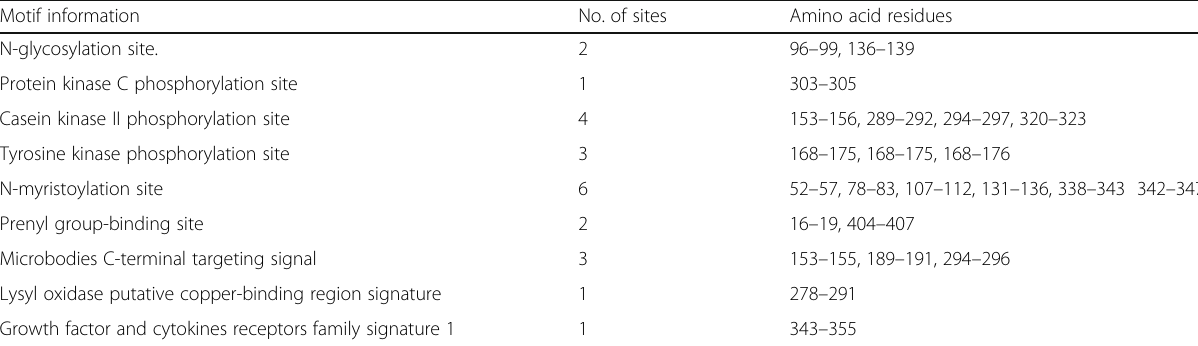
Table 3 Motif regions present in the protein sequence Motif information No. of sites Amino acid residues N-glycosylation